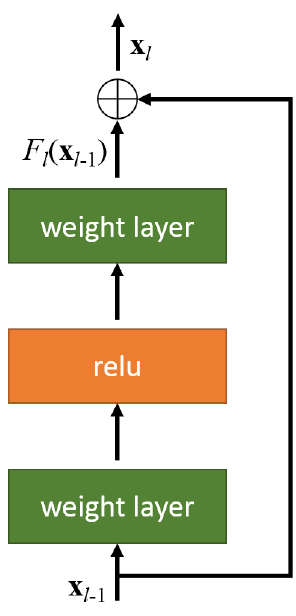
Figure 3. Graphical representation of a Residual Net